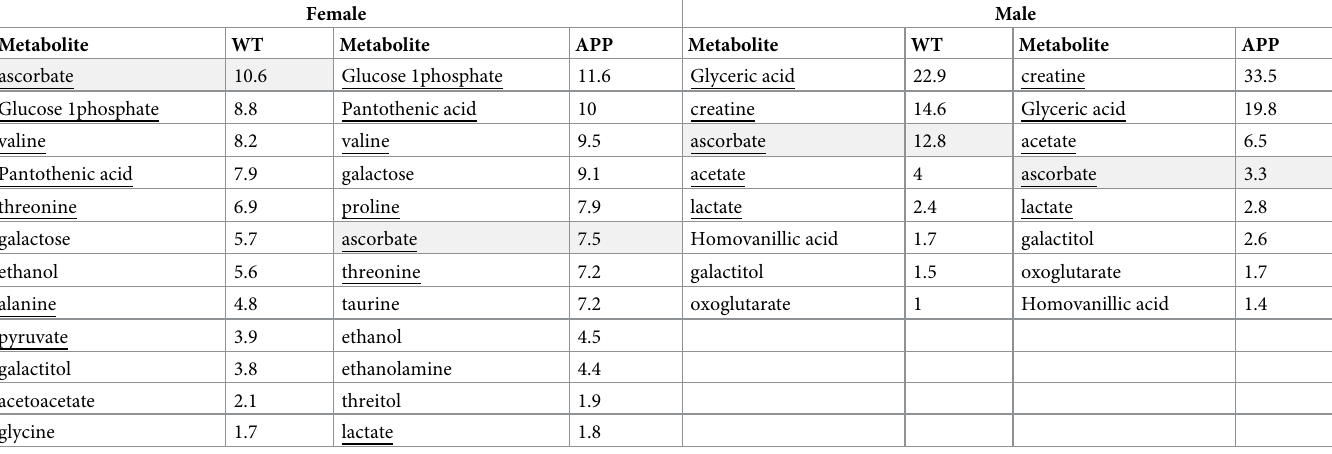
Table 2. Ranking of the connectedness of CSF metabolites with blood-based